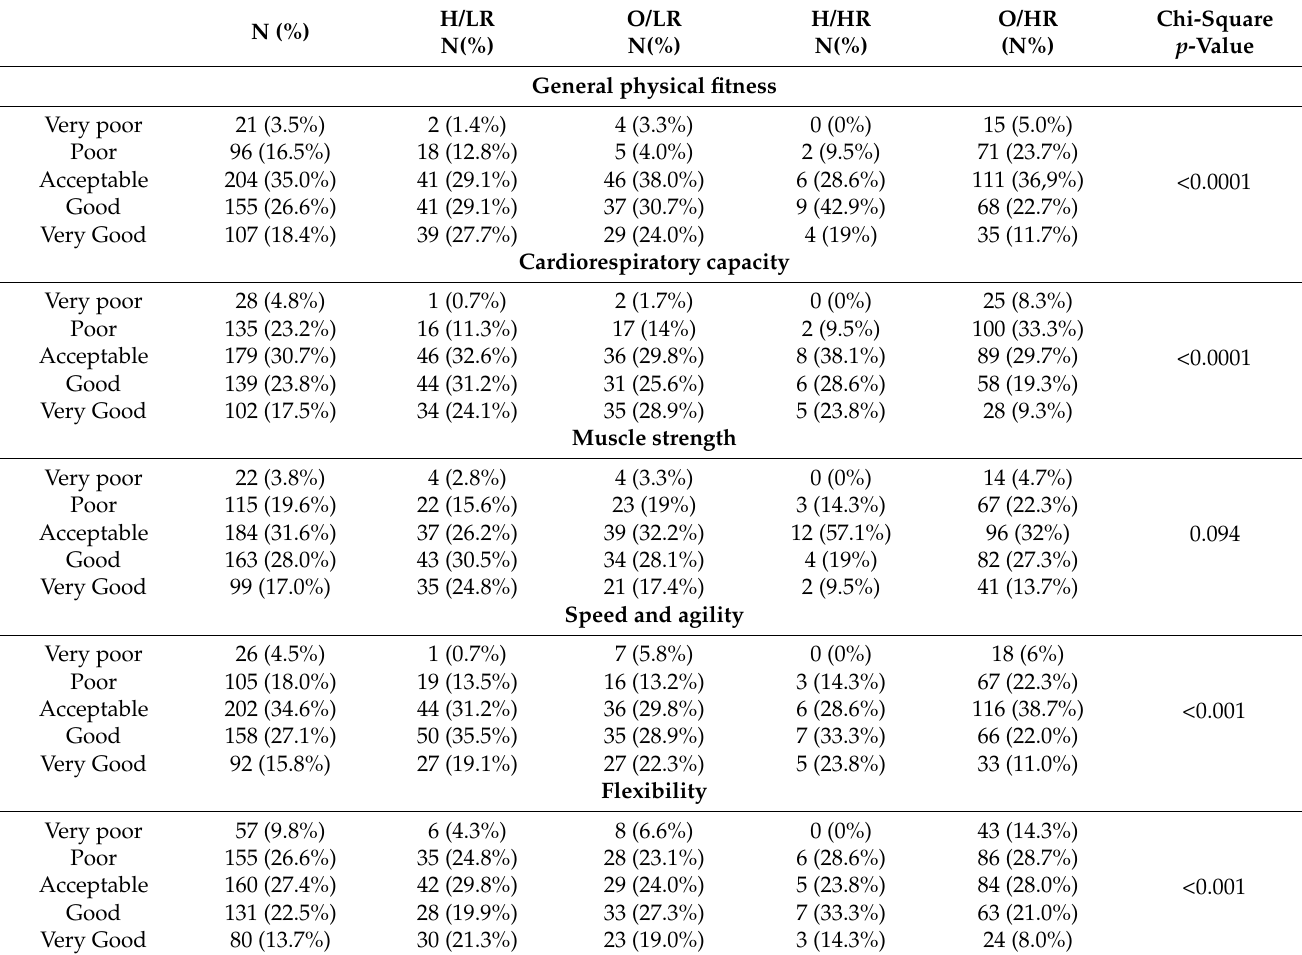
Table 2. Perception of physical fitness according to sub-classification of